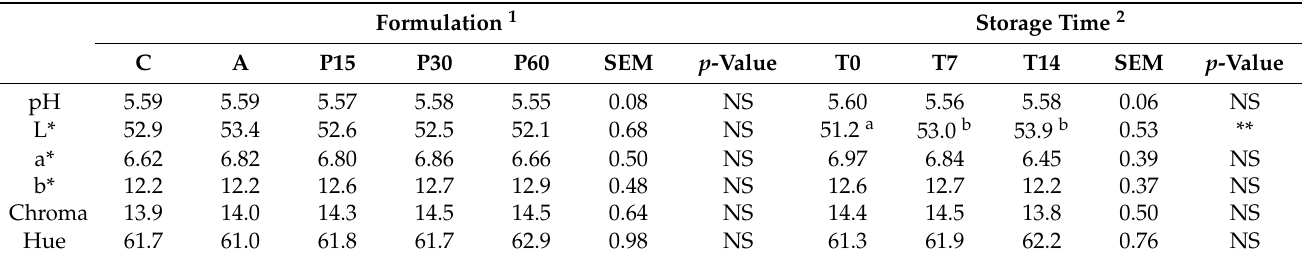
Table 4. Estimated marginal means and standard error of the mean (SEM) of the pH values and color parameters of the raw pork